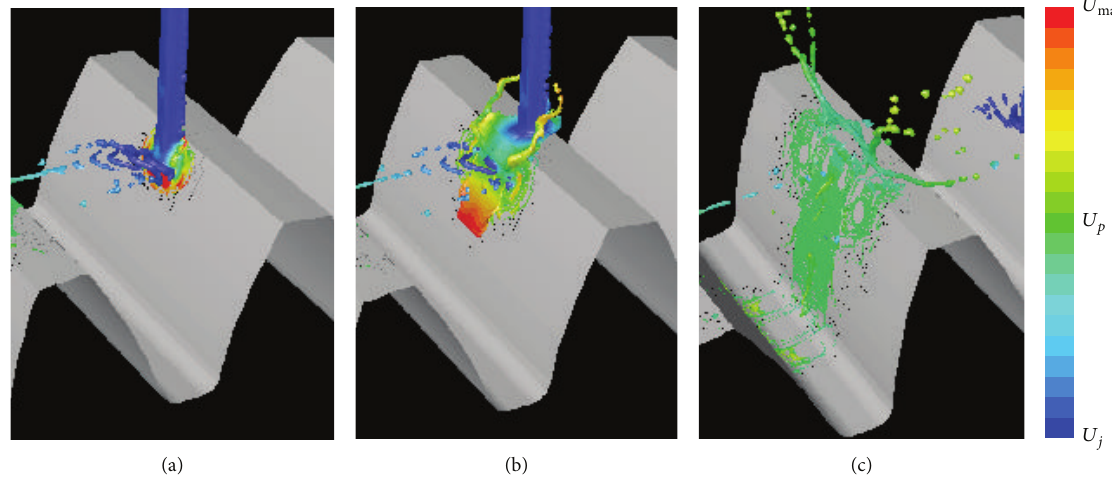
Figure 14: Run 3: contour plot of velocity on the liquid